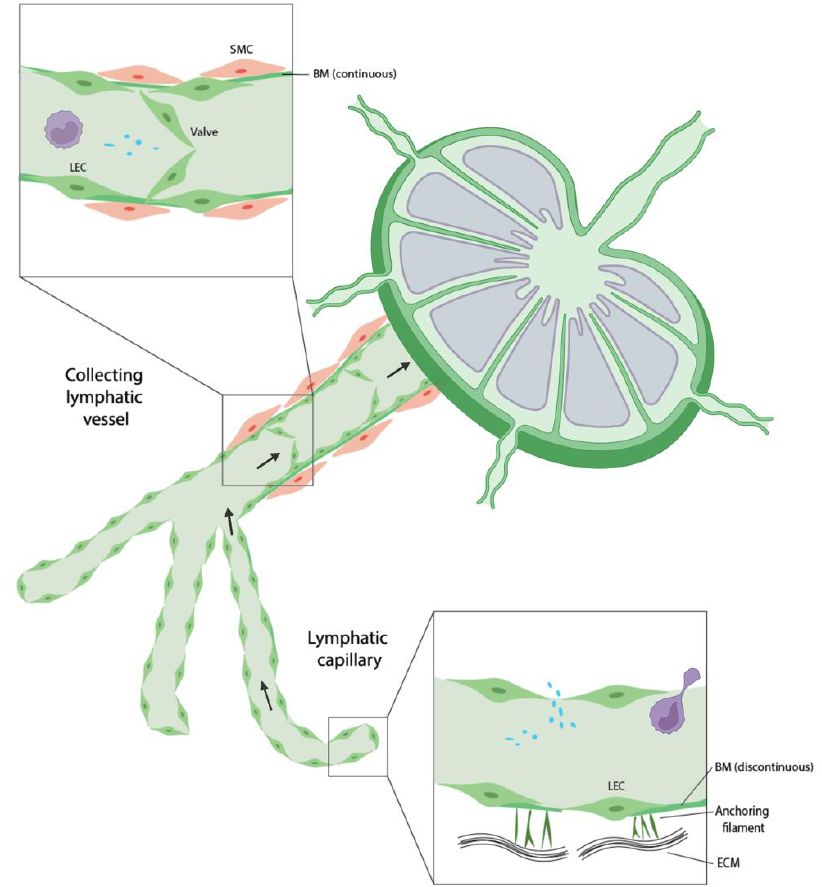
Figure 1. Schematic representation of lymphatic vessels. Lymphatic capillaries and collecting lymphatic vessels possess distinct characteristics.